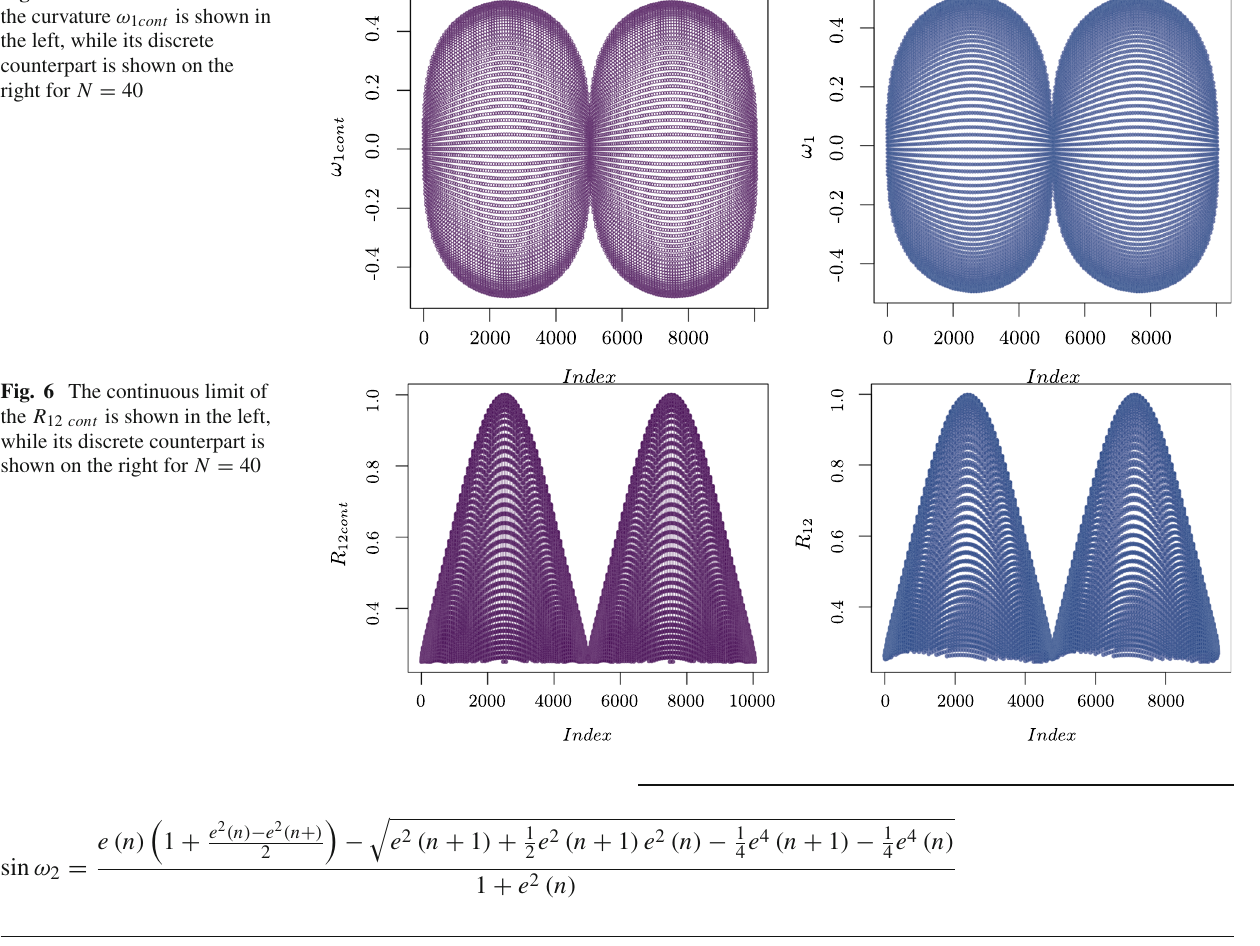
Fig. 6 The continuous limit of the R 12 cont is shown in the left, while its discrete counterpart is shown on the right for N =